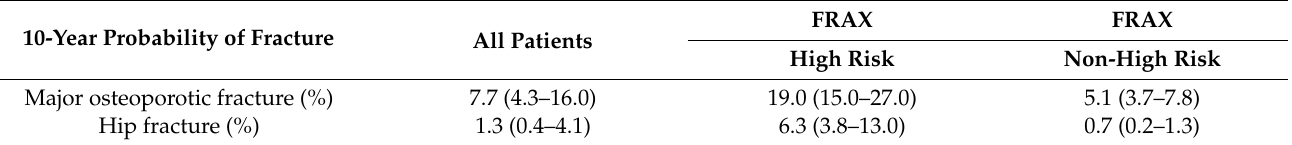
Table 2. The 10-year probabilities of major osteoporotic and hip fractures based on the